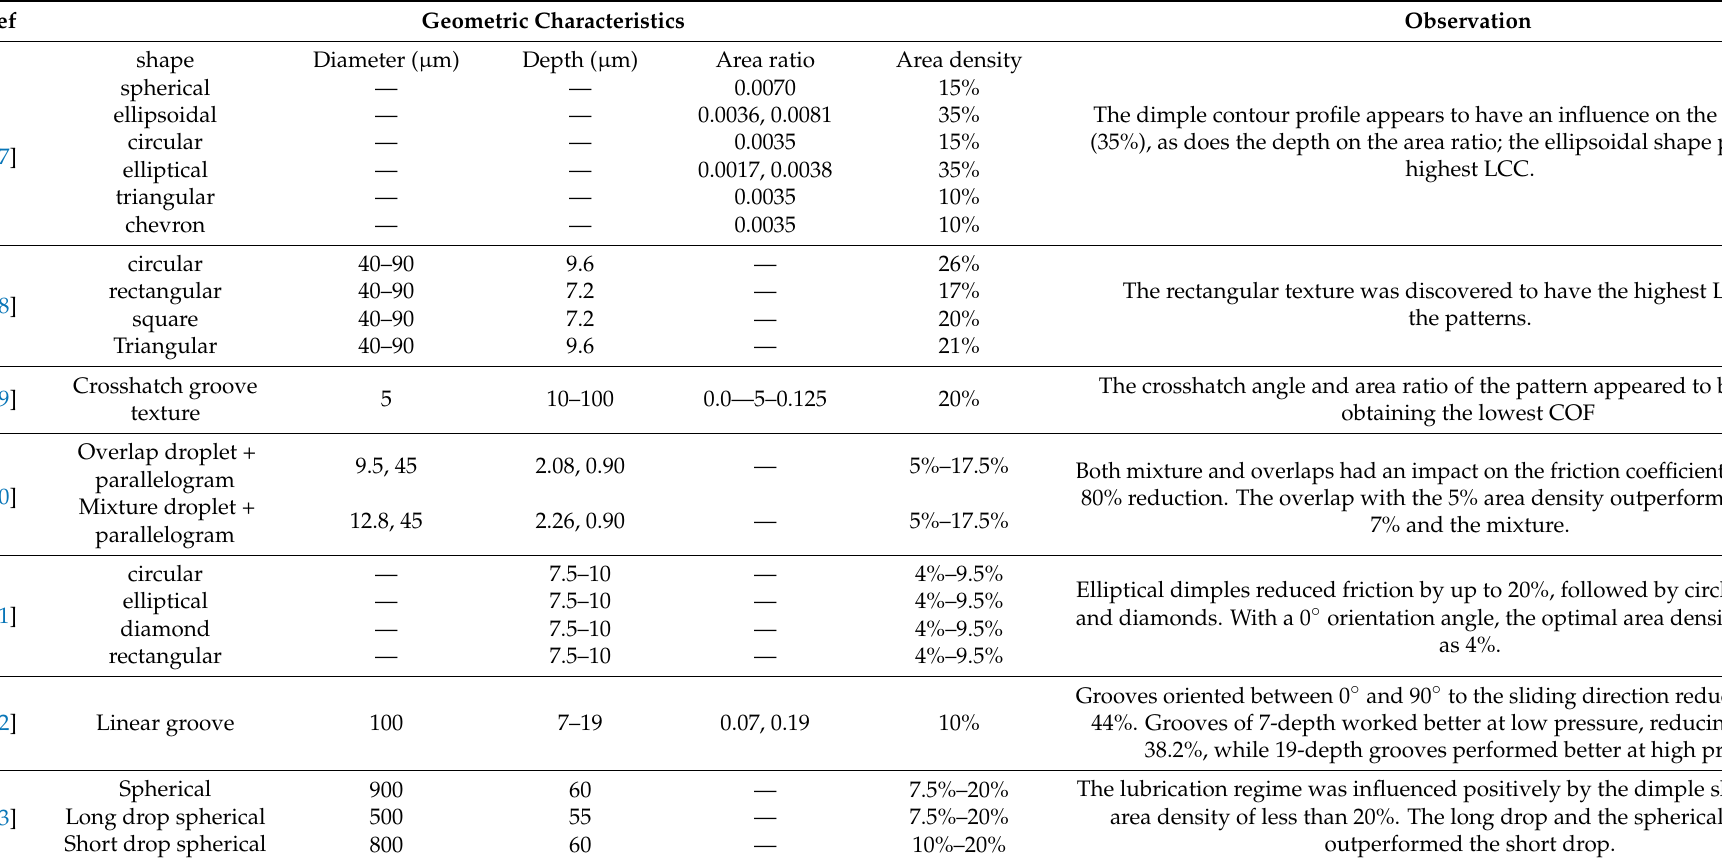
Table 2. Influence of various geometric characteristics on tribological